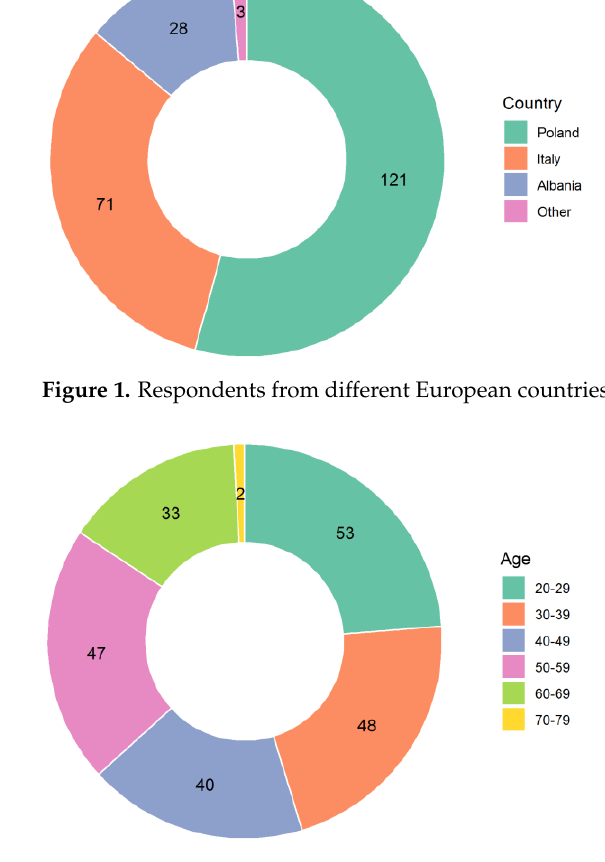
Figure 2. Age ranges of the respondents.